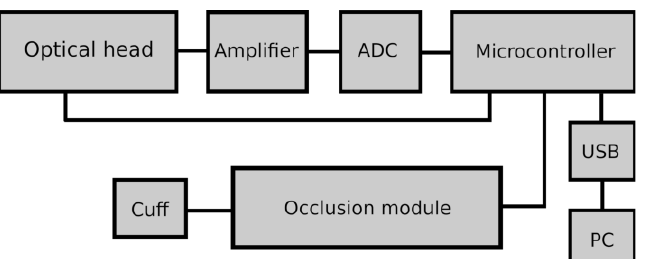
Figure 2. Block scheme of the AngioExpert utilizing FMSF [14]. Reproduced from Katarzynska, J; Lipinski, Z.; Cholewinski, T., Piotrowski, L; Dworzynski, W.; Urbaniak, M.; Borkowska, A.; Cypryk, K.; Purgal, R.; Marcinek, A.; Gebicki J. Non-invasive evaluation of microcirculation and metabolic regulation using flow mediated skin fluorescence (FMSF): Technical aspects and methodology. Rev Sci. Instrum. 2019 , 90 , 104104; DOI:10.1063/1.5092218, with the permission of AIP Publishing.